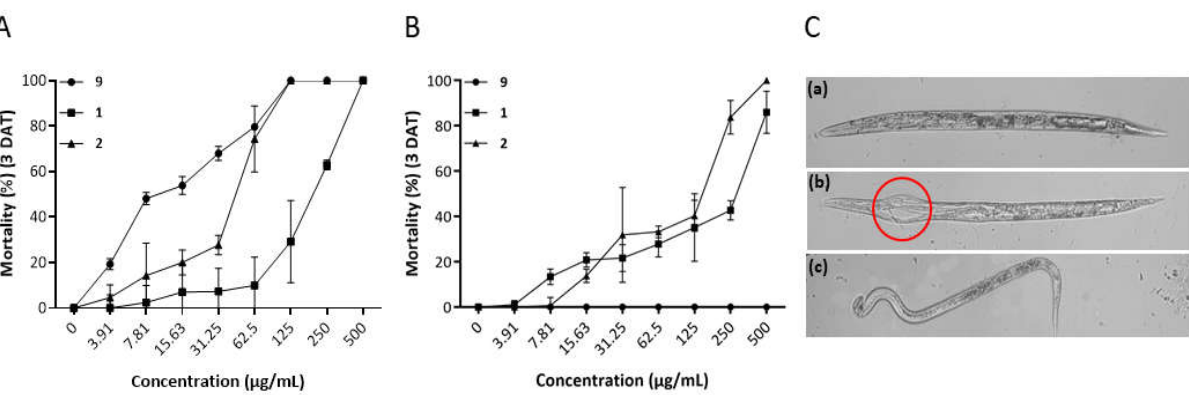
Figure 3. In vitro nematicidal activity of grammicin ( 9 ), compound 1, and compound 2 against second-stage juveniles of Meloidogyne incognita ( A ), fourth larval stage (L4) worms of Caenorhabditis elegans ( B ), and morphological variations in M. incognita ( C ) treated with grammicin (a), compound 2 (b), and control (c). Each value represents the means ± standard deviation with three replicates against M. incognita . Relationships among means were analysed with one-way analysis of variance and Duncan’s multiple-range test ( p < 0.05). Table 1. LC 50 values for Meloidogyne incognita second-stage juvenile mortality subjected to various compounds, including two purified metabolites produced by the grammicin-knockout mutant strain (TR74) of Xylaria grammica.